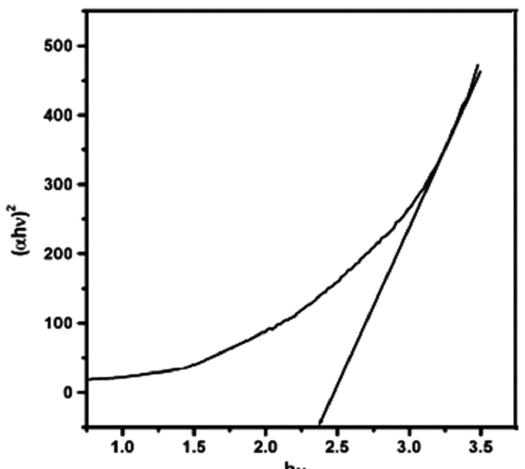
Figure 6. Dielectric constant of CuSe thin films.